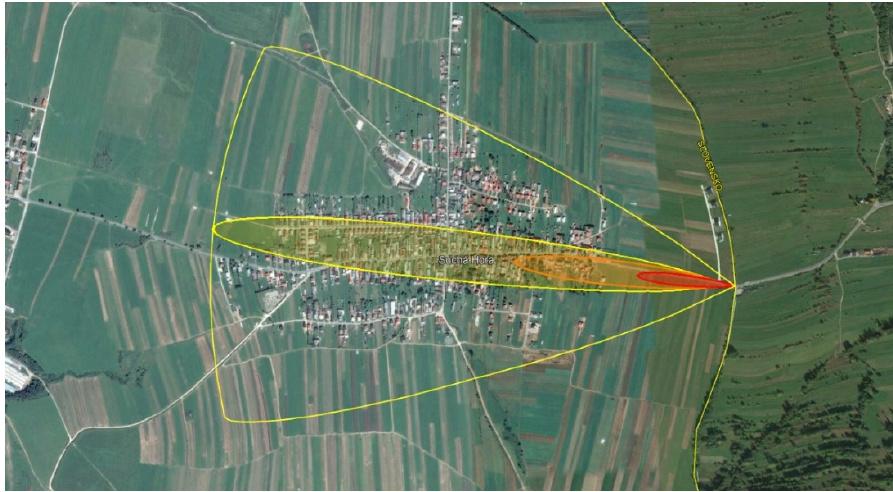
Figure 13. Graphical representation of the dispersion of a dangerous substance at the Suchá Hora border crossing [24,25].